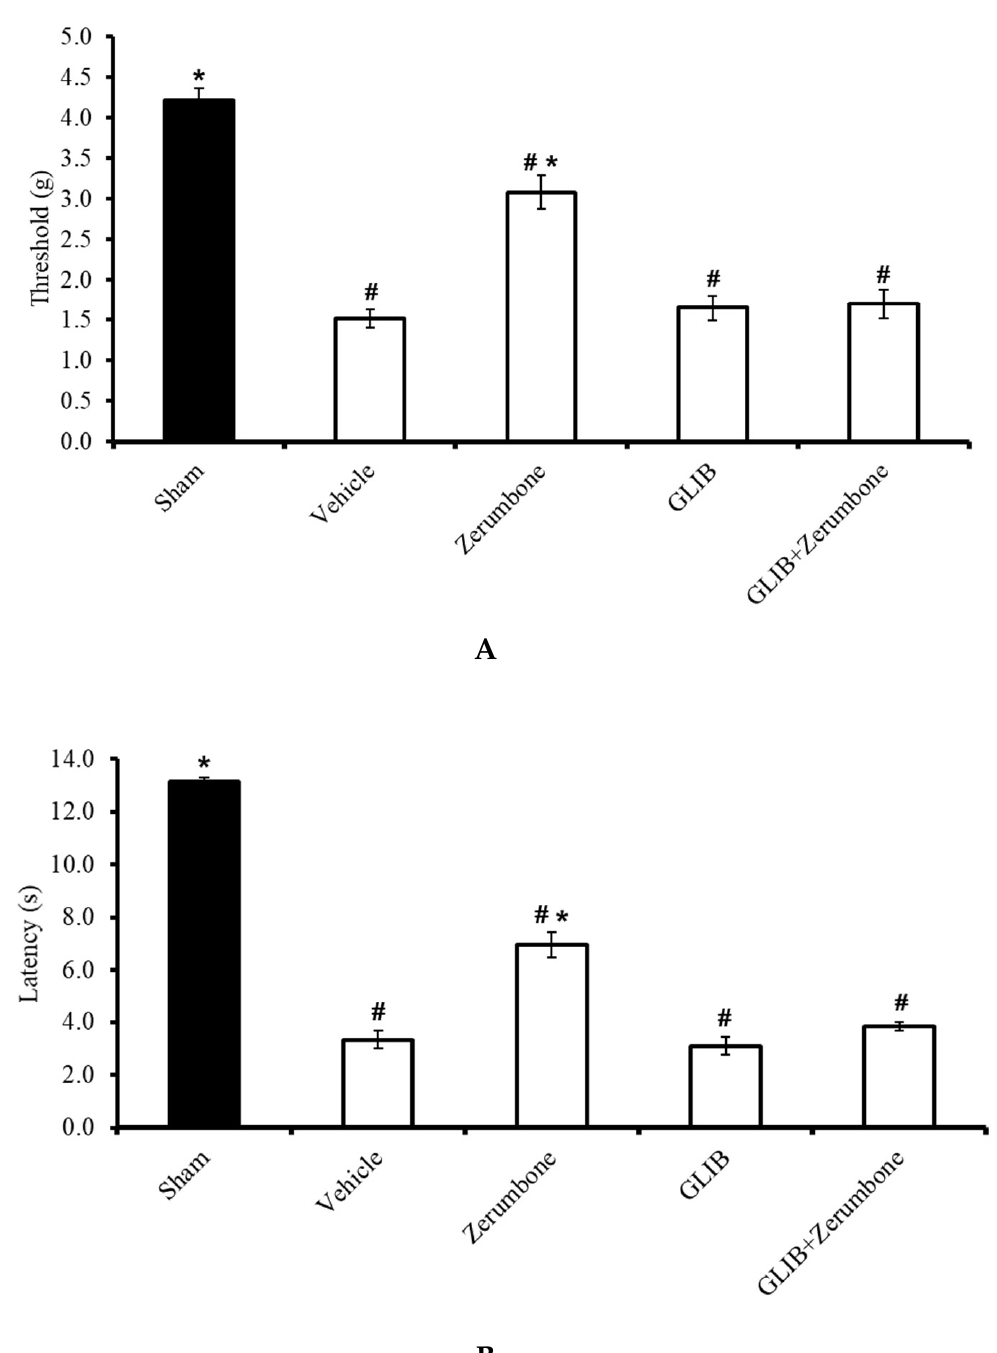
Figure 2. Effect of zerumbone (10 mg/kg; i.p.) and pre-treatment with an ATP-sensitive K + channel blocker (glibenclamide, GLIB; 10 mg/kg; i.p.) on the responses toward ( A ) mechanical allodynia and ( B ) thermal hyperalgesia on CCI-induced neuropathic pain in mice. Each column represents the mean ± SEM; n = 8 mice per group. Note: # significantly different ( p ≤ 0.05) than sham group; * significantly different ( p ≤ 0.05) than vehicle group (one-way ANOVA followed by Tukey’s post hoc test).